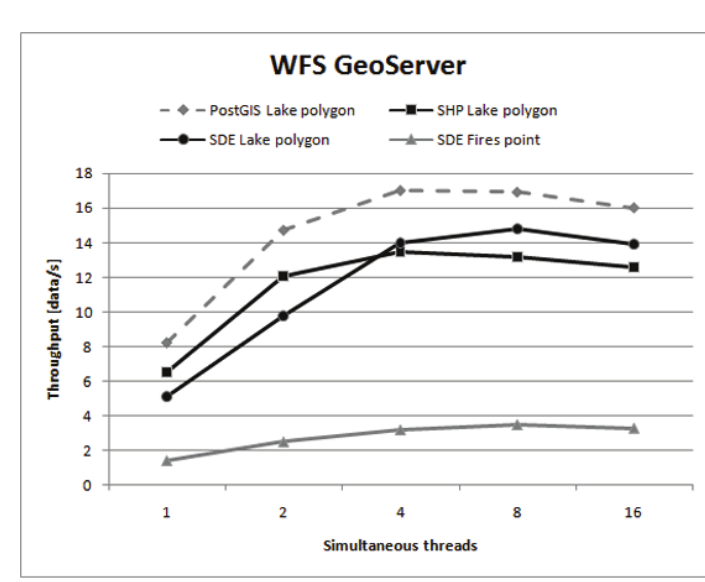
Figure 4: WFS Geoserver test